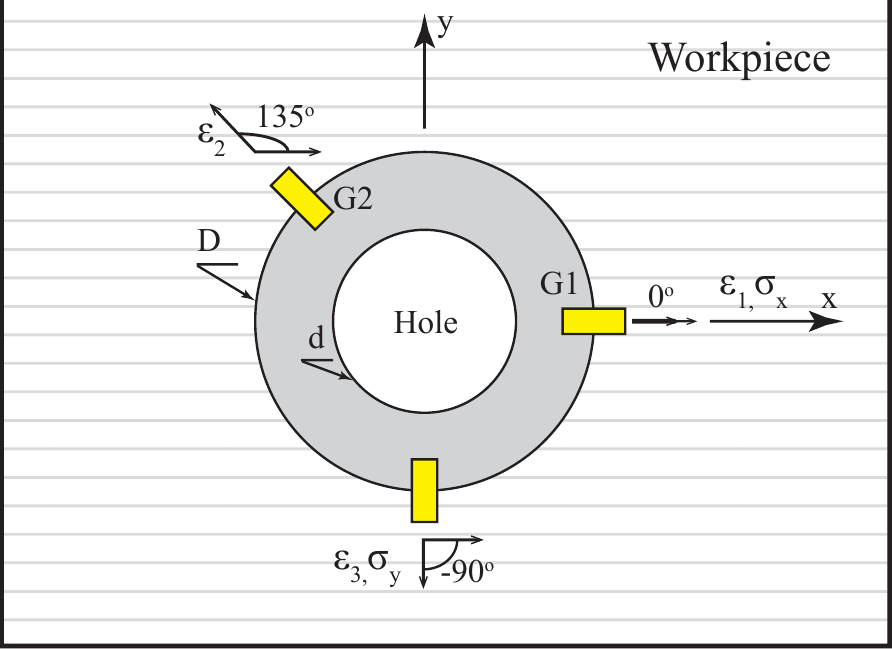
Figure 1. Typical configuration of 45 ◦ rosette strain